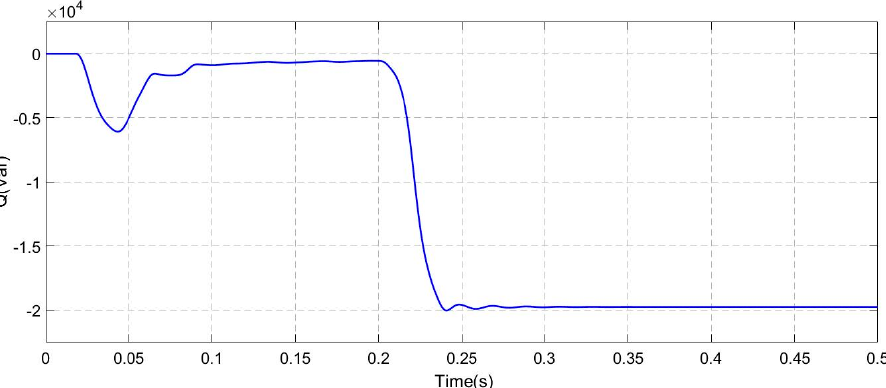
Figure 9. Waveform of reactive power consumption in PV inverter under reverse power control mode.